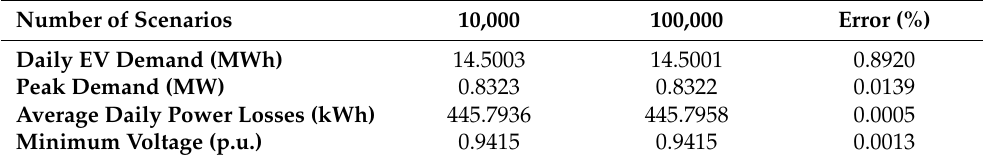
Table 6. Sensitivity Analysis